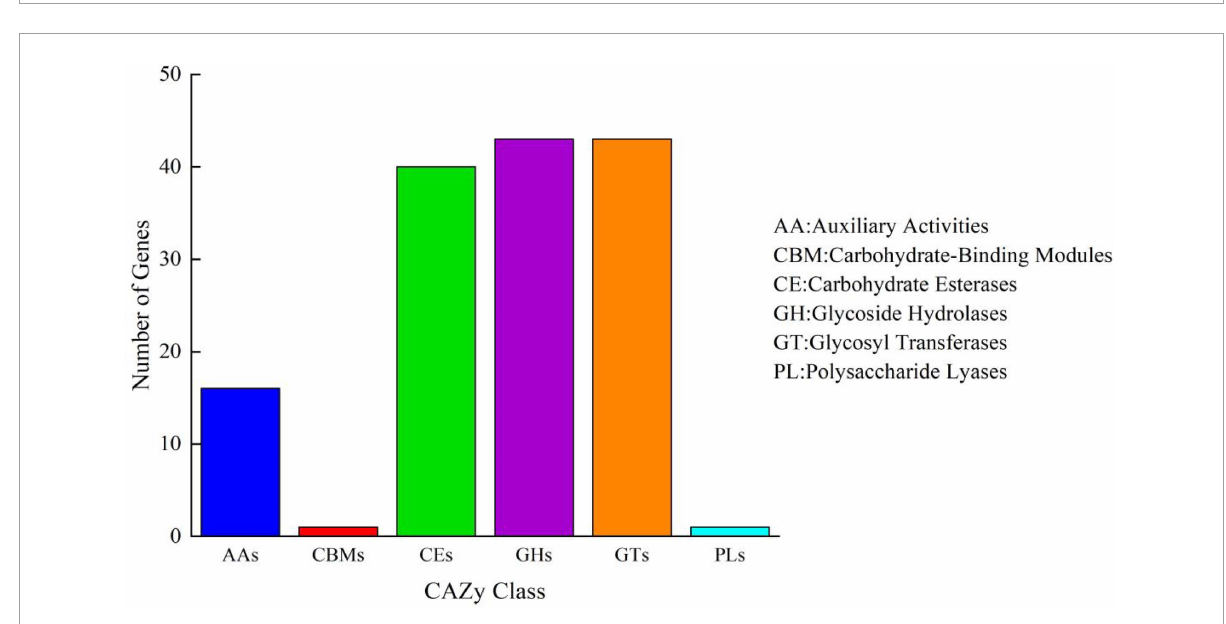
FIGURE5 Carbohydrate-active enzyme family classification of B. aryabhattai TCI-16. Abscissa represents CAZy family classification and ordinate represents the number of genes.